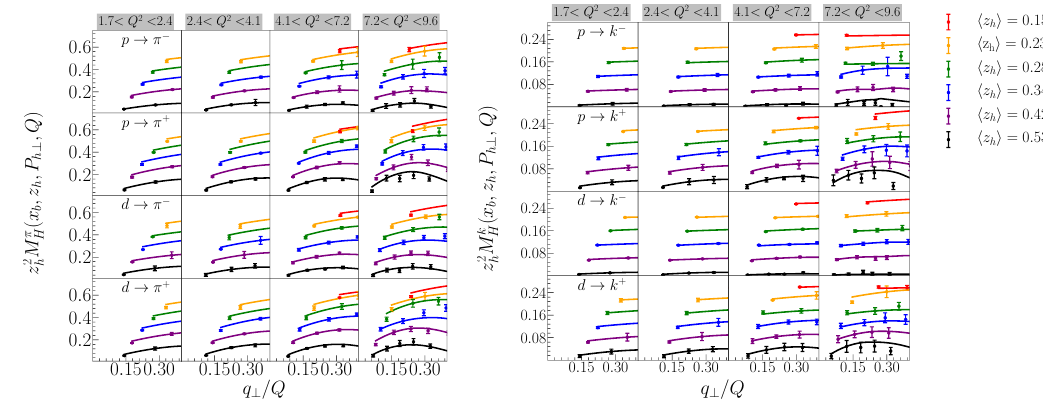
Figure 3 . The experimental data for Drell-Yan lepton pair production measured by the E288 collaboration [59] plotted as a function of q ⊥ /Q are compared with the normalized theoretical curve. Different colors represent different invariant mass of the lepton pair from 4 < Q < 5 , 5 < Q < 6 , 6 < Q < 7 , 7 < Q < 8 , 8 < Q < 9 , 11 < Q < 12 , 12 < Q < 13 , 13 < Q < 14 GeV, respectively. Three panels correspond to different energies for incident proton beams: 200 GeV (left), 300 GeV (middle), and 400 GeV (right).